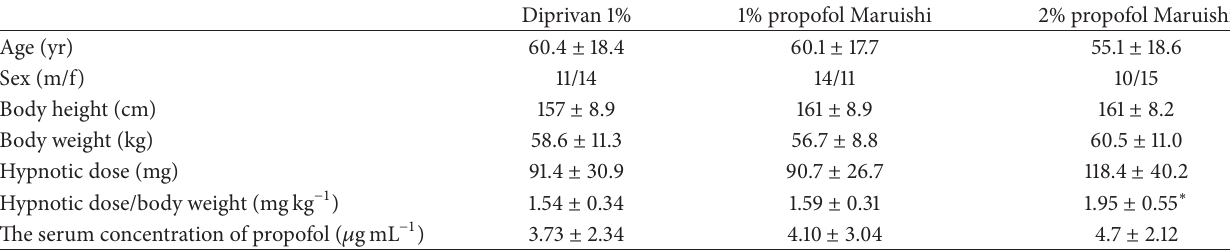
Table 1: Patients’ demographic data and the results.